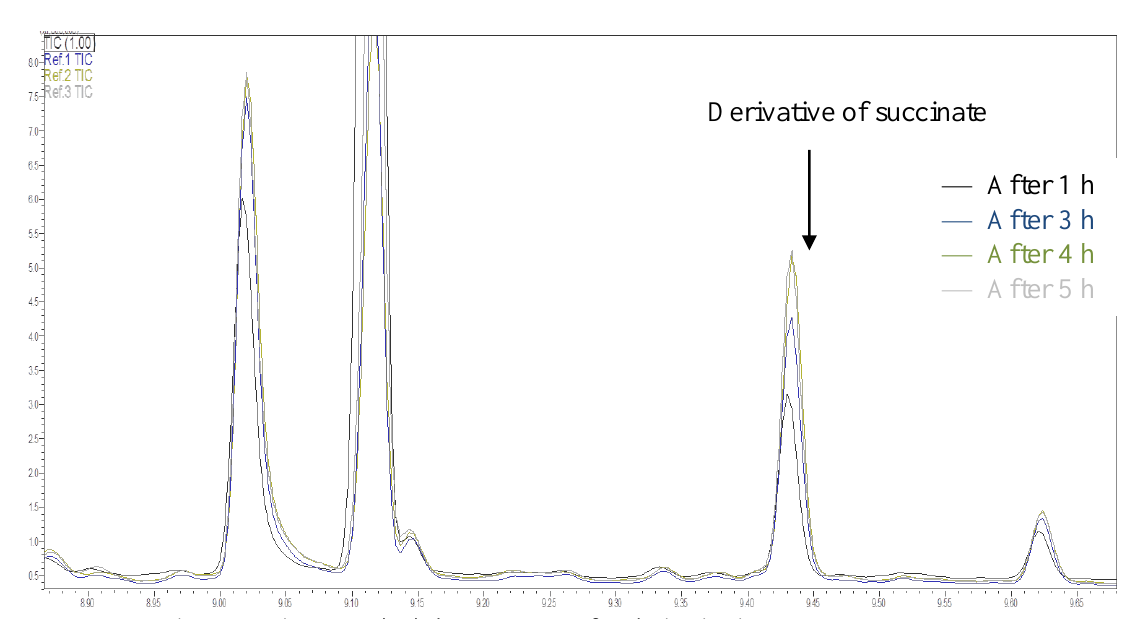
Fig. 2. Succinate standard chromatogram after derivatization at room